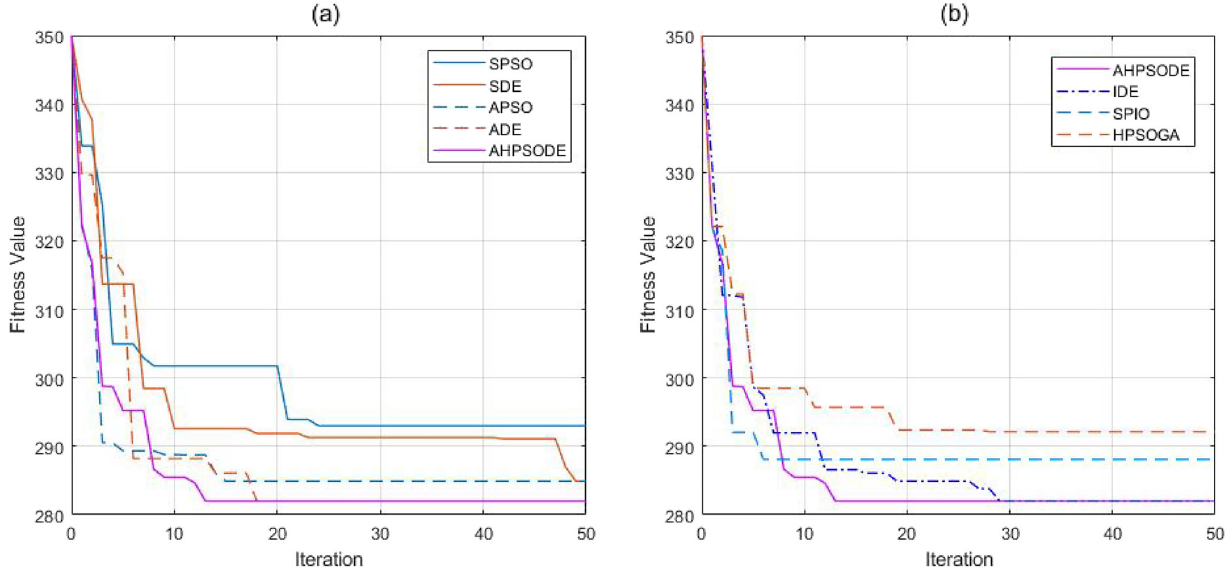
Fig. 11 Convergence curve of different algorithms in solving the target assignment problem of multi-UAV reconfiguration Table 9 Parameter settings for different algorithms Algorithm